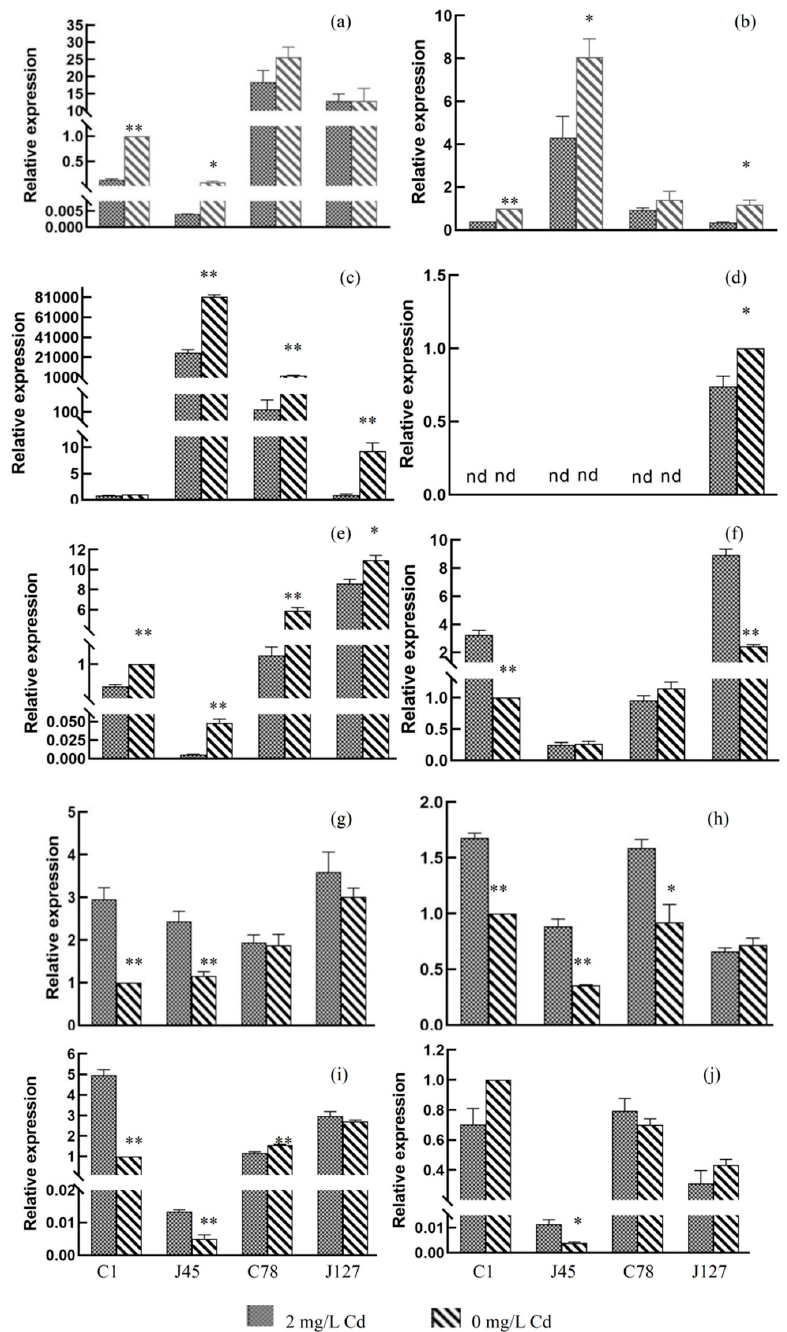
Figure 9. RT-qPCR analysis of the expression level of ten candidate genes in different samples. ( a ) gene-K441DRAFT-552345, ( b ) gene-K441DRAFT-600384, ( c ) gene-K441DRAFT-611738, ( d ) gene-K441DRAFT-660325, ( e ) gene-K441DRAFT-681328, ( f ) gene-K441DRAFT-653729, ( g ) gene- K441DRAFT-654069, ( h ) gene-K441DRAFT-668187, ( i ) gene-K441DRAFT-672999, and ( j ) gene- K441DRAFT-603024. * p < 0.05; ** p < 0.001. The relative expression changes of the target gene in the